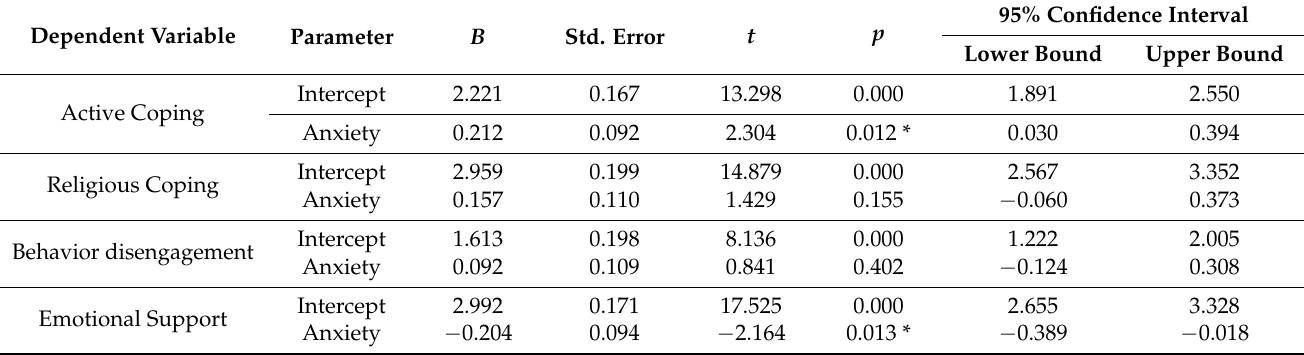
Table 4. Parameter estimates for the prediction of anxiety on coping strategies adopted by